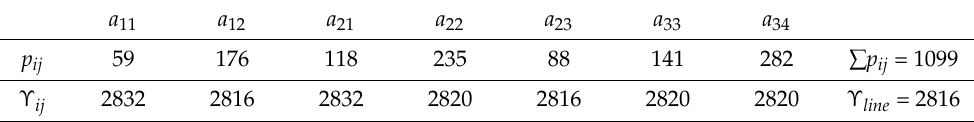
Table 6. Final ALB solution proposed by this